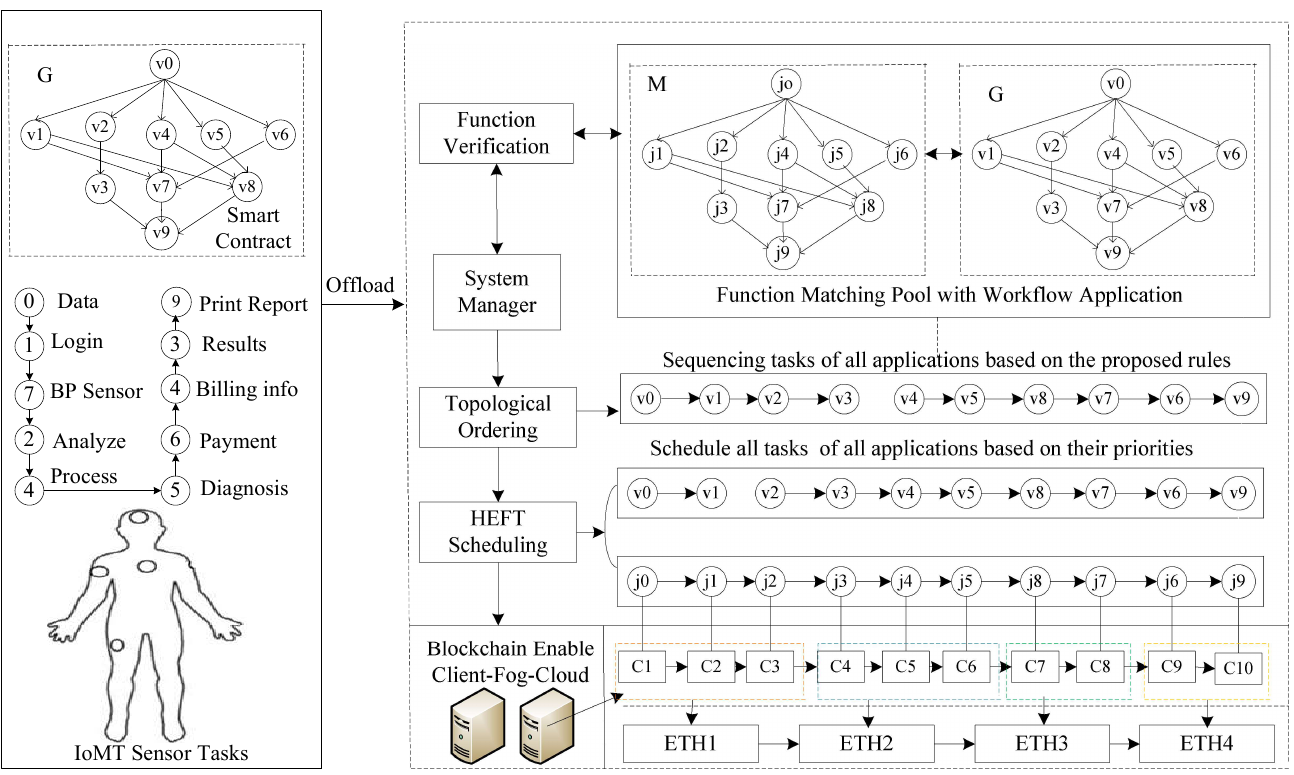
Figure 1. Smart-Contract Ethereum Aware Client-Fog-Cloud Assisted Healthcare